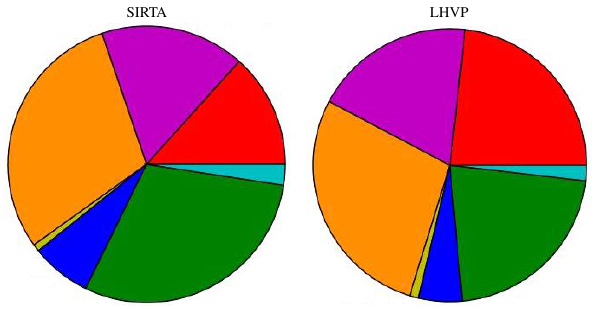
Fig. 13. Averaged composition of OM at the SIRTA (left) and LHVP (right) sites modeled with “H 2 O- Ref”. Red: POA, purple: SOA formed form oxidation of primary SVOC, orange: OM from bound- ary conditions used for the European simulation (long-range transport of OM), yellow: SOA formed from aromatics oxidation, blue: SOA formed from monoterpenes oxidation, green: SOA formed from sesquiterpenesoxidation,aqua: SOAformedfromisopreneoxidation